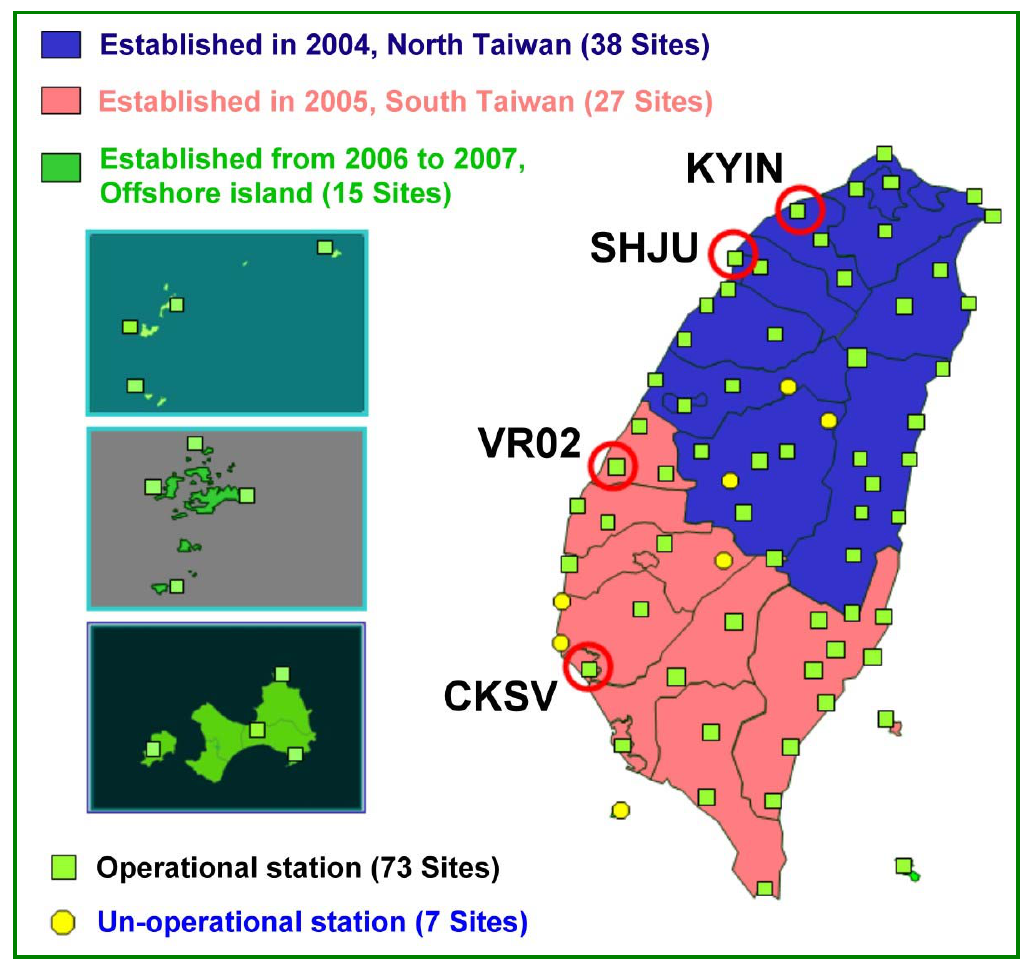
Figure 5. Distribution of e-GPS observation stations (Courtesy of NLSC,